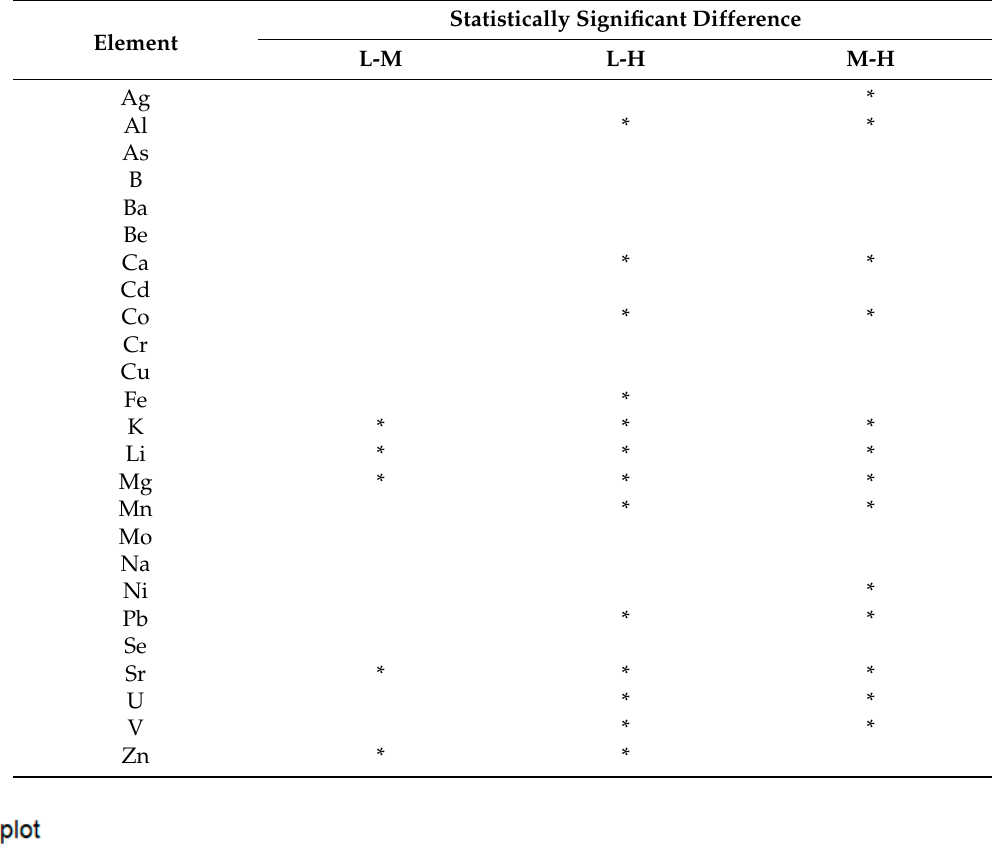
Table 2. Statistically significant differences in elemental content in the dried needle samples between the sampling sites when the respective site combination is marked with *.